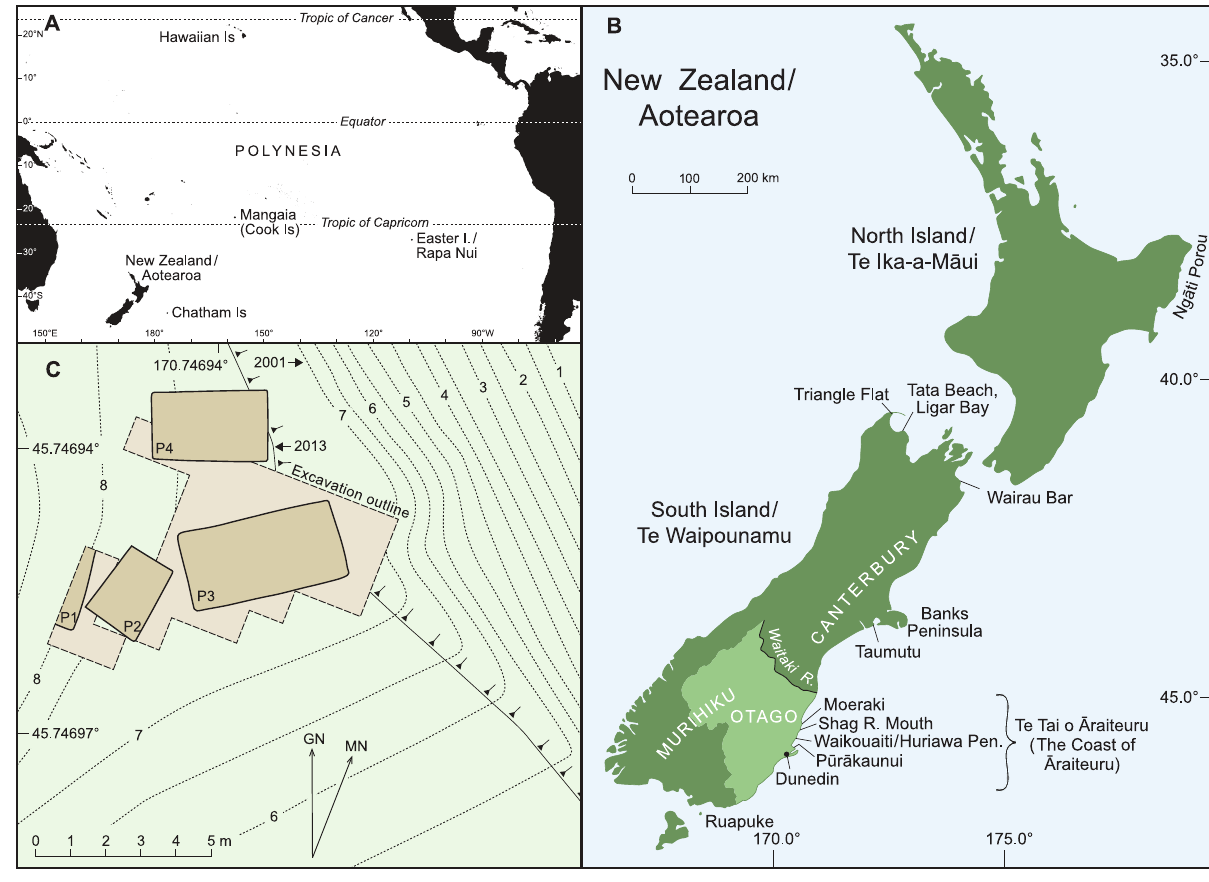
Fig 1. Location maps and archaeological site plan. (A) Polynesia in the setting of eastern Oceania, after map modified from SVG file ‘World map blank without borders’, GNU Free Documentation License, CC BY-SA 4.0, adding island locations from public domain map data available from U.S. Geological Survey (USGS), National Geospatial Program. (B) New Zealand/Aotearoa after map data sourced from Land Information New Zealand (LINZ) Data Service licensed for reuse under CC BY 4.0 and locations in [28,30,33,36,66,74].Traditional Murihiku incorporates Otago region to Waitaki River (cadastral border enclosing lighter fill), as well as the southern, modern Southland region (Fig 6.8 in [30]), [33]. Shown generally only are Canterbury region north of Waitaki River and the Ng ā ti Porou tribal area of eastern Te Ika-a-M ā ui. (C) Plan of P ū r ā kaunuiarchaeological pit complex, I44/21 S dune terrace. Elevation above mean sea level (DVD1958) is determined by DGPS.